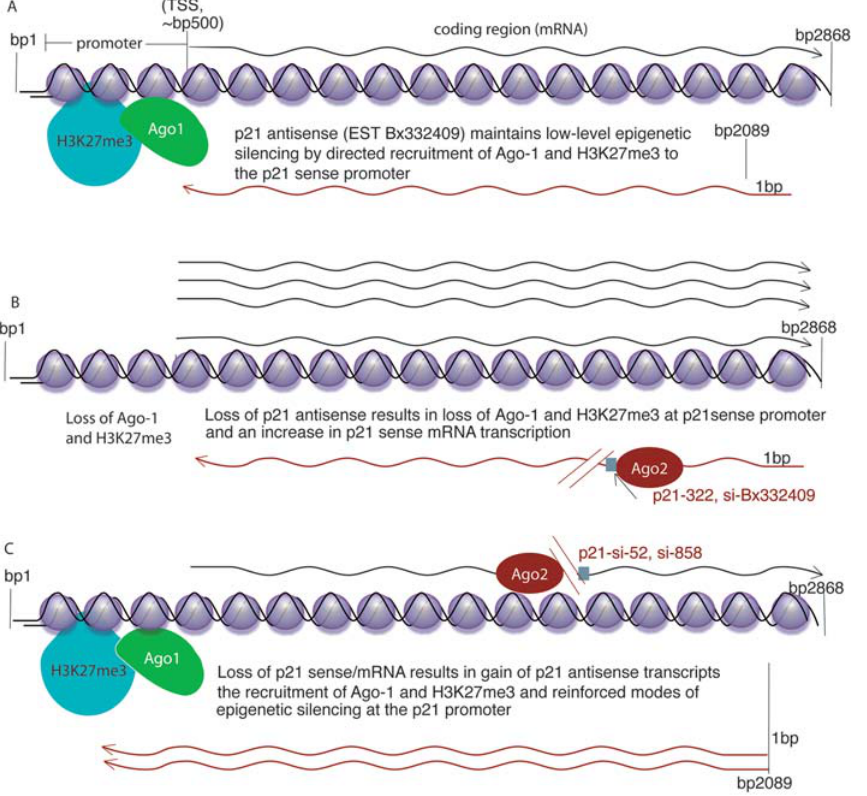
Figure 5. Model for bidirectional RNA mediated transcriptional regulation of gene expression in human cells. (A) Bidirectional transcription is presumed to exert a controlled equilibrium of endogenous p21 gene expression, whereby the antisense transcript directs Ago-1 dependent low-level epigenetic regulation, H3K27me3, at the p21 sense/mRNA promoter. (B) Upon suppression of the antisense transcript the directed H3K27me3 is diminished, allowing for enhanced p21 sense/mRNA transcriptional gene activation. (C) When p21 sense/mRNA expression is suppressed, a release of regulatory pressure is exerted on the p21 antisense transcript allowing for p21 antisense directed Ago-1 and H3K27me3 enrichment at the p21 sense/mRNA promoter. Ago-1 has been observed to be required for the early stages of RNA directed transcriptional gene silencing [9], thus the early recruitment of Ago-1 to the p21 sense promoter may function as a re-enforcing loop to exert stable epigenetic silencing on p21 gene